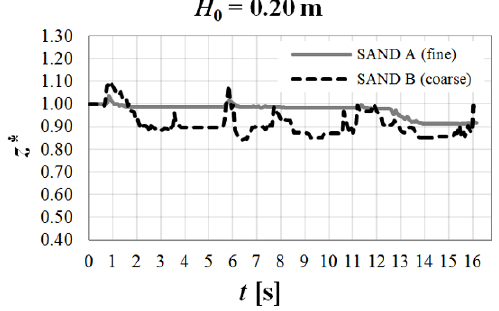
Figure 5. Experimental time evolution of z * at the dike upstream reference abscissa ( −δ ) for Tests A1 and